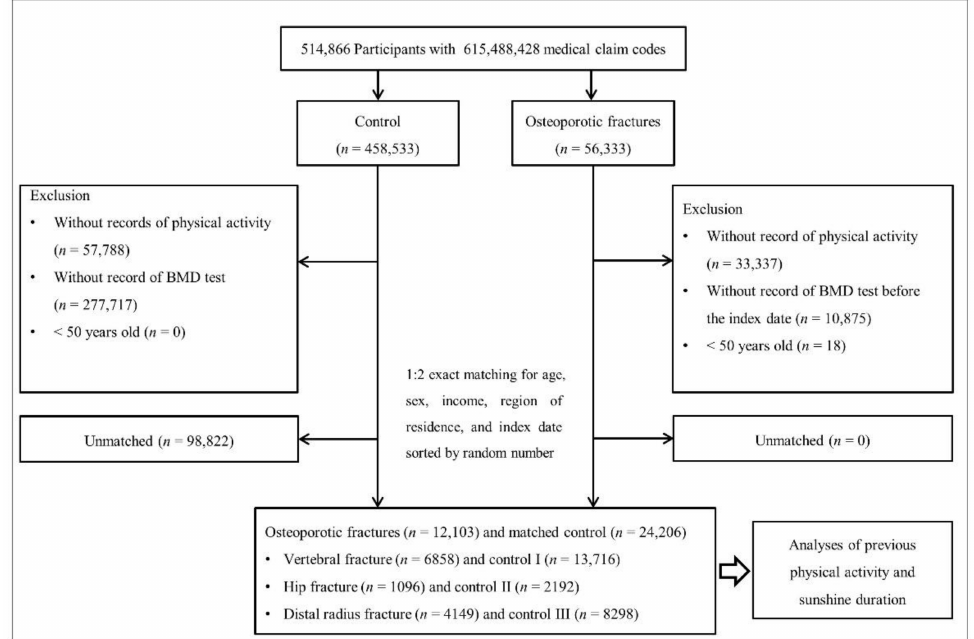
Figure 1. A schematic illustration of the participant selection process that was used in the present study. Of a total of 514,866 participants, 12,103 osteoporotic fractures were matched with 24,206 con- trol participants for age, sex, income, and region of residence. BMD, bone mineral